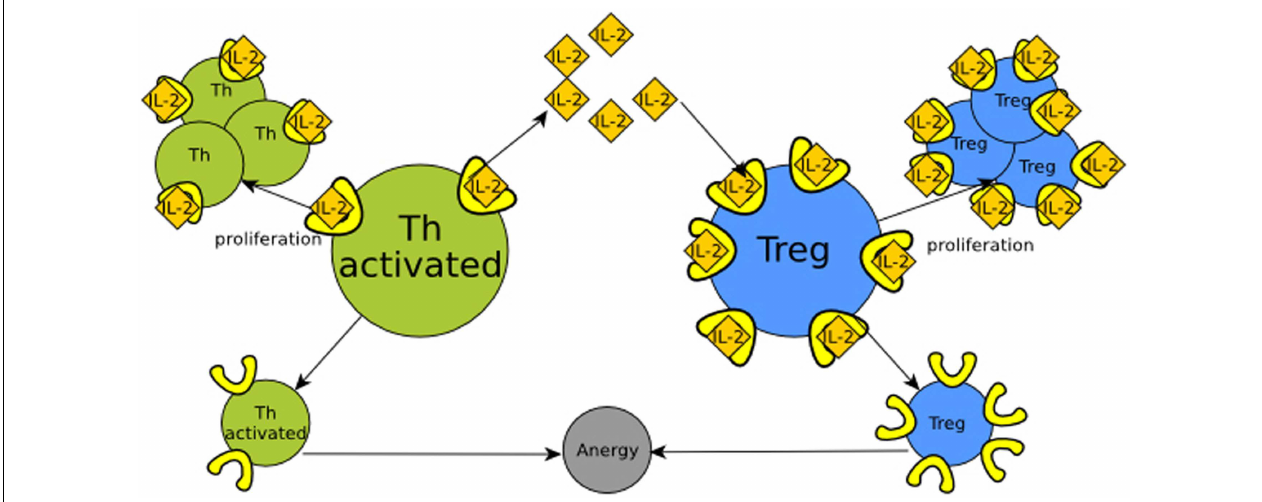
anergic and rapidly die. T regulatory cells (Treg, in blue) also have IL-2 receptors. This makes Treg cells capable of sequestering IL-2 and then analogous to the B module in Figure 1 . The retroactivity and loads effects become significant as T regulatory cells have more receptors than Th cells, which enables them to regulate by competition with the Th population.